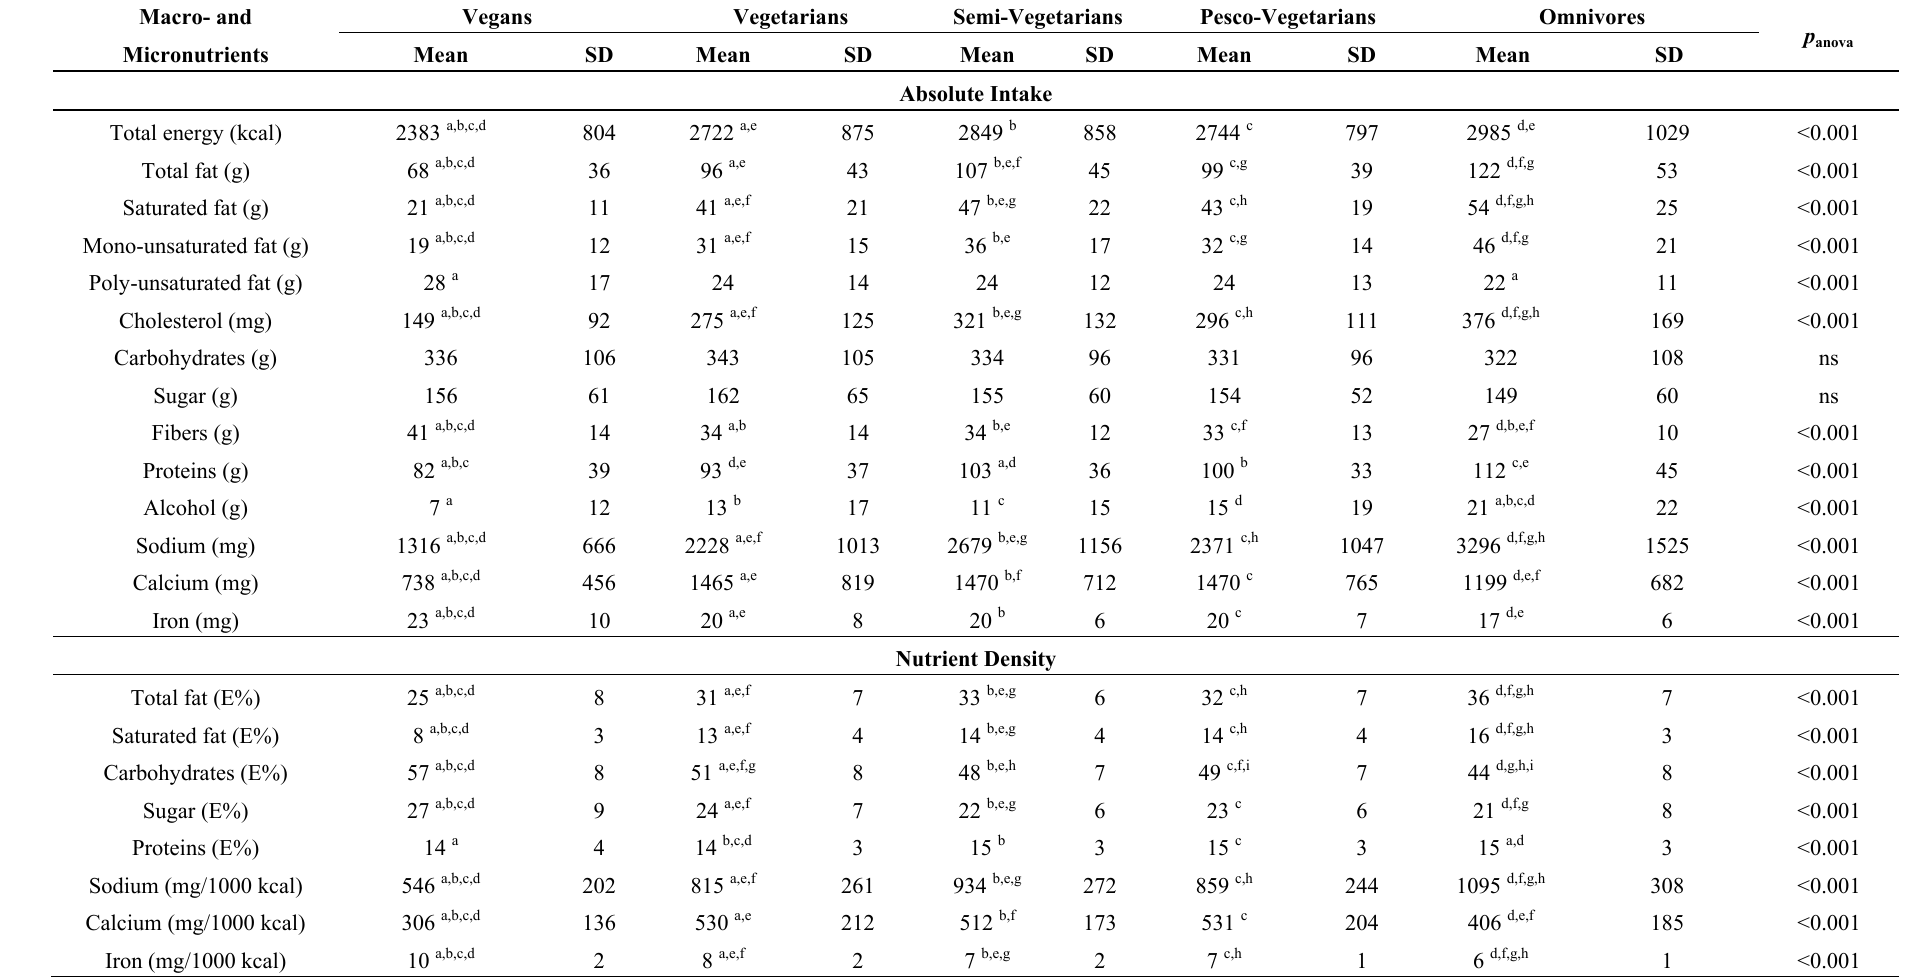
Table 2. Nutritional intake across the dietary patterns ( n =